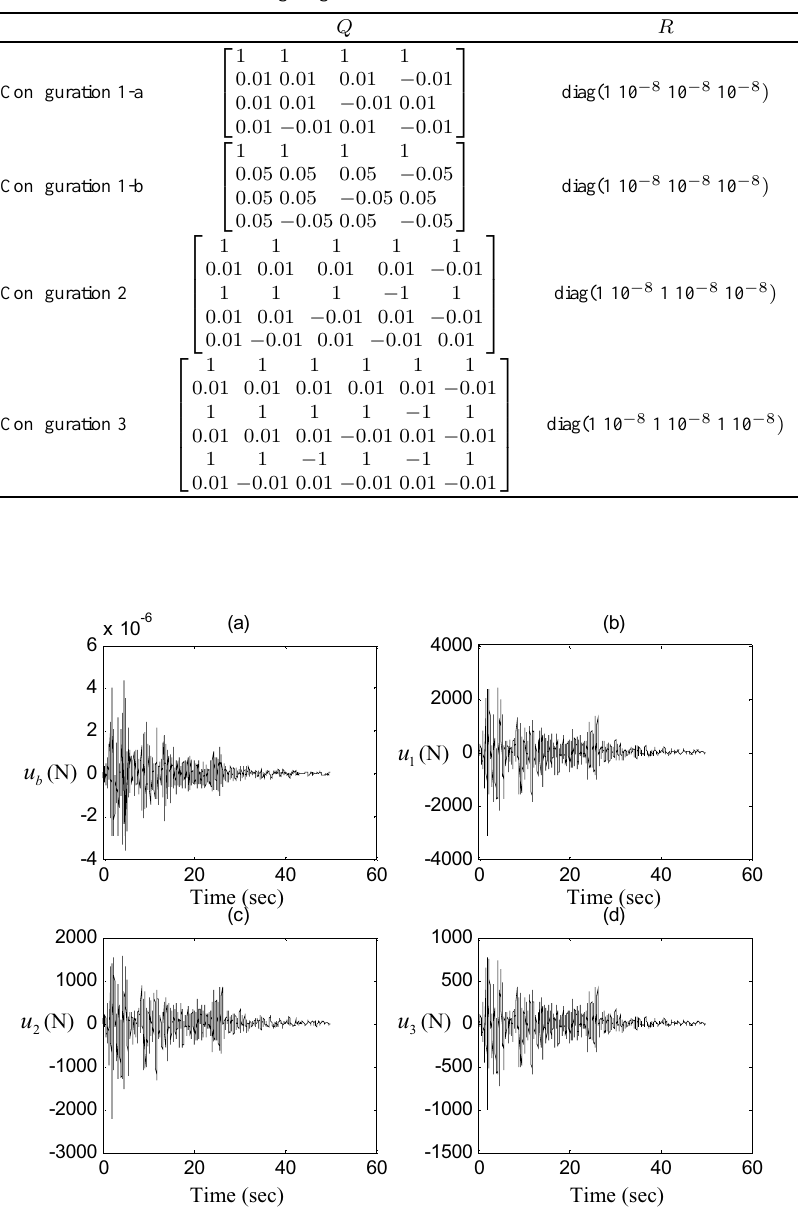
lowered. With regard to the passive approach, the reduction of the mass/stiffness of the added elements is of great importance. It should be noted that the mass/stiffness of these elements can be determined once the active controller is specified via knowledge of the matrices Q and R . For the illustrative example at hand, it was verified that reducing the mass/stiffness can be attained by lowering the magnitudes of Q and R